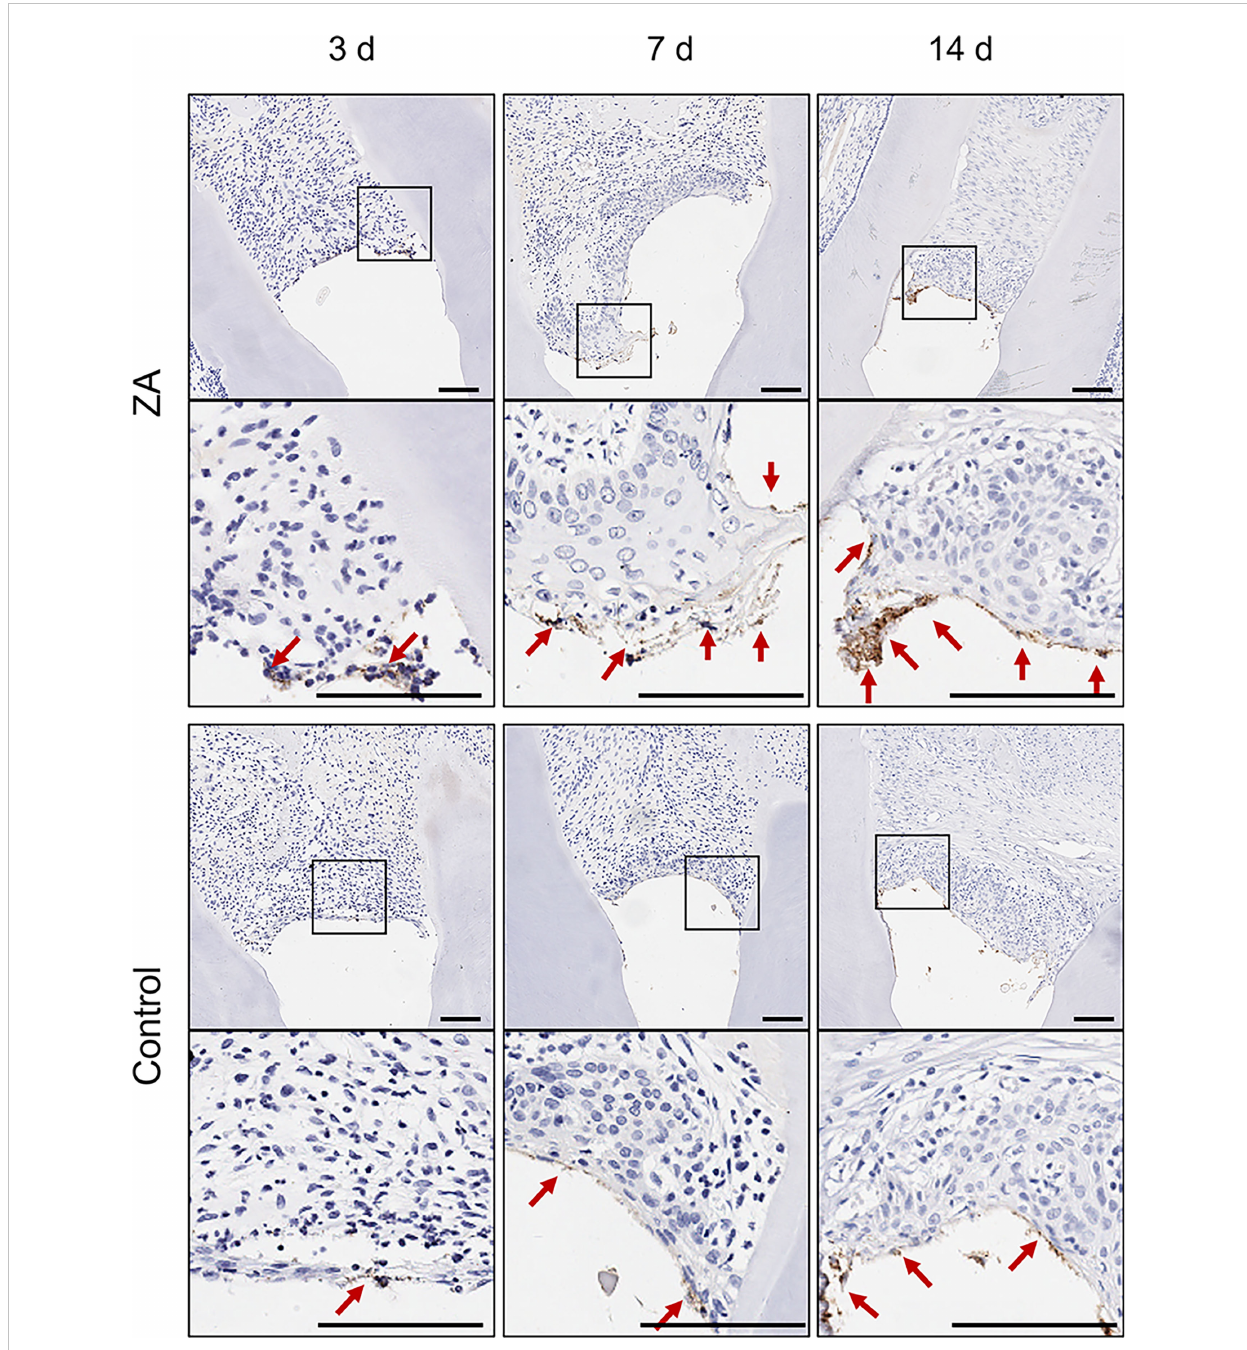
FIGURE 6 P. gingivalis in gingival tissues of the ZA group and the control group. The images in the second panel of each group are enlarged views of the boxed areas in the above images. Red arrows indicated the P. gingivalis infect the gingival epithelial layer. Scale bars = 100 m